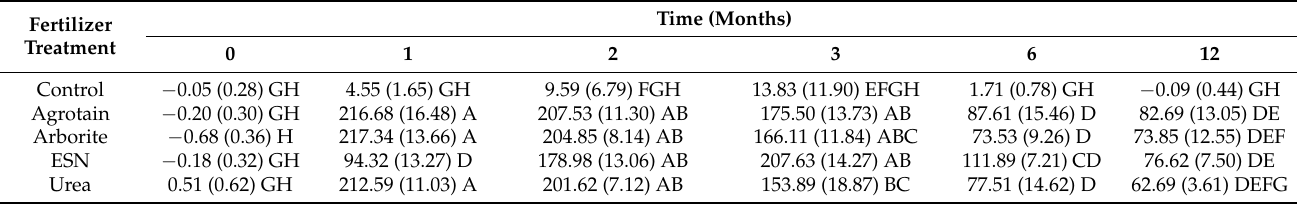
Table 6. Responses of δ 15 N (‰) of competing vegetation to fertilization treatments and time. Table entries are means ( ± standard error of the mean) for each fertilizer treatment × time combination ( n = 8). Means throughout the table marked with the same letters did not differ significantly ( α =